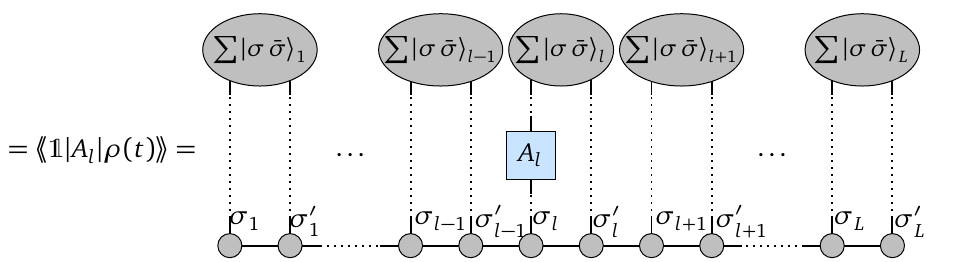
Figure 3: Visualization of the computation of local expectation values using the con- traction of the MPS with a local operator A and the trace generating state | 1 〉 in the l (cid:80) | σ ¯ σ 〉 transformed basis (see Eq. 24) represented by a product of spin pairs cov- σ l ering associated sites corresponding to the ket and bra part of the density matrix at site l . The density matrix is also calculated in the transformed basis as Eq. 25. Note that the observable A does not change with this l